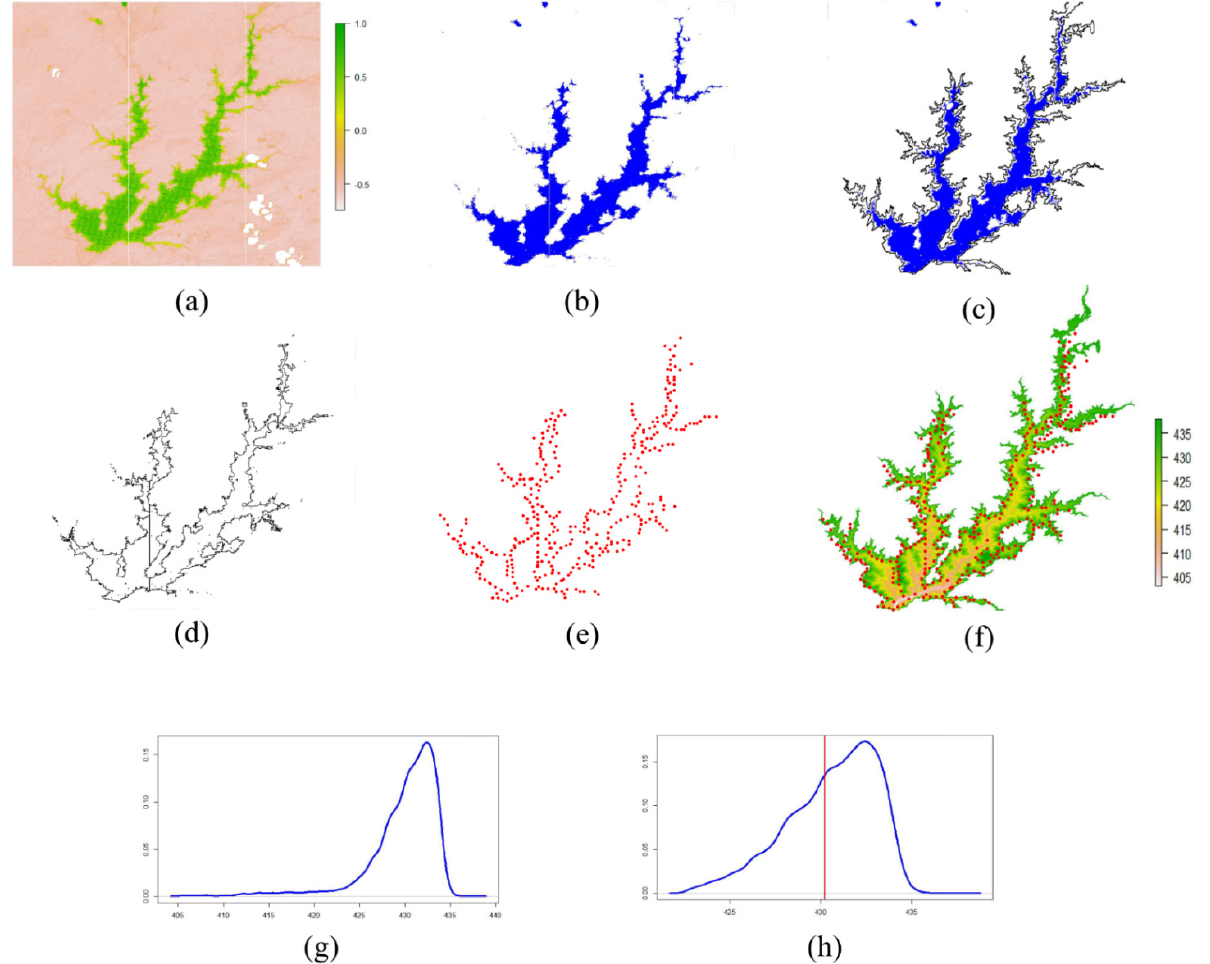
Figure 2. Water level estimation process: ( a ) MNDWI images; ( b ) thresholding MNDWI images; ( c ) masking MNDWI images by a buffer derived from DEM, considering the maximum elevation at 437 m (2 m higher than the maximum operational limits) to eliminate disconnected water bodies and WL values arising from misclassified pixels; ( d ) creating a polygon from raster MNDWI masked image; ( e ) converting polygons to border points; ( f ) extracting elevations at point positions from DEM; ( g ) removing outliers from extracted elevation dataset; ( h ) water level estimation ( Yc ) from the me- dian statistic.